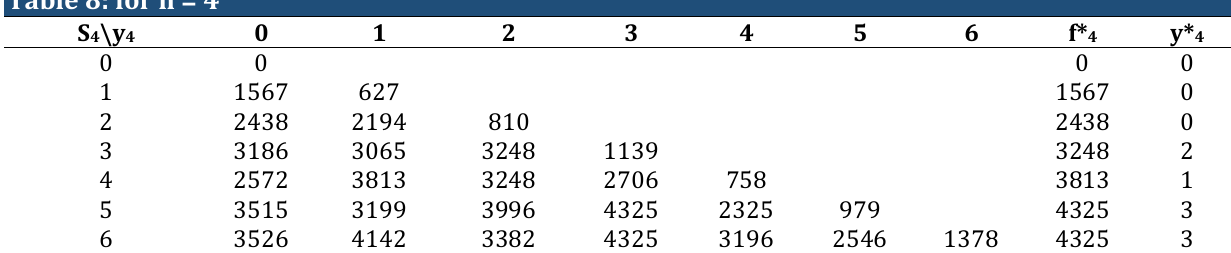
Table 8: for n = 4